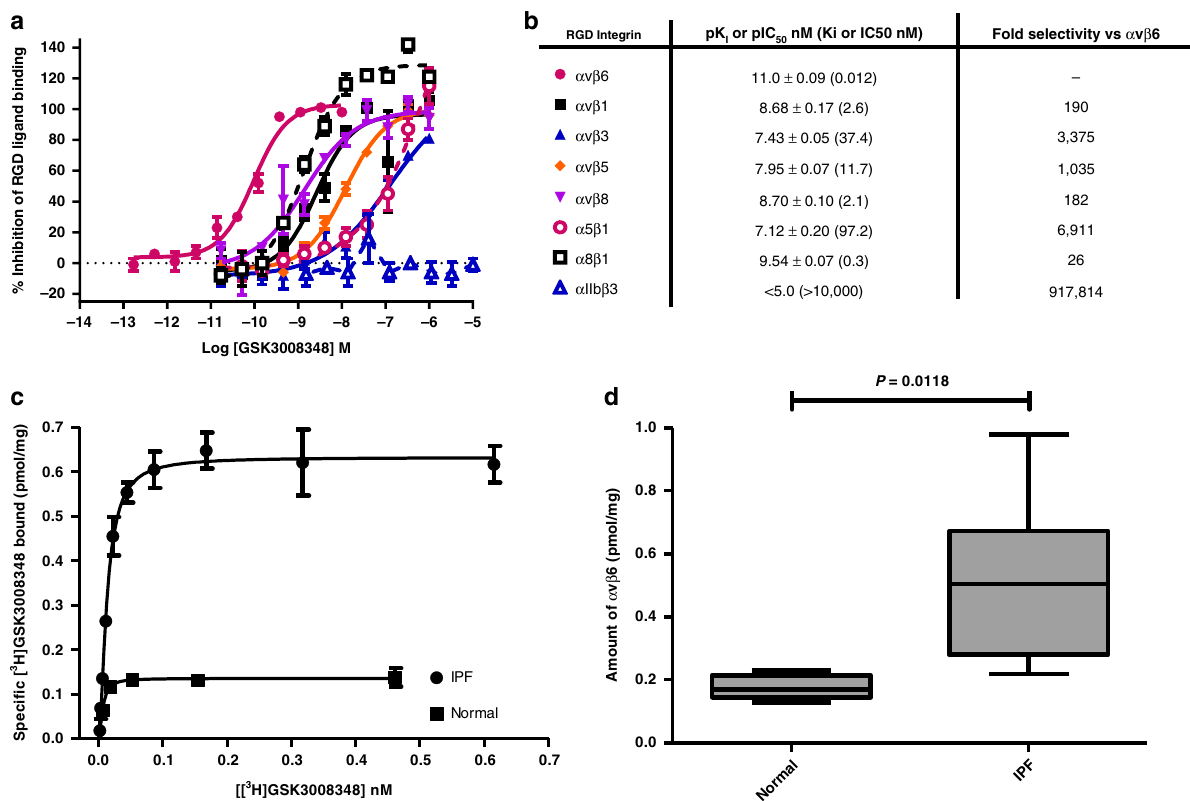
Fig. 2 High af fi nity and selectivity of GSK3008348 for the α v β 6 integrin. a Competition binding curves of GSK3008348 against the RGD integrins (mean ± SEM; n = 4). b p K I af fi nity or pIC 50 values ( α IIb β 3 only) for GSK3008348 against the RGD integrins with fold-selectivity for α v β 6 (mean ± SEM; n = 4 – 6). c Representative saturation binding curves for [ 3 H]GSK3008348 in normal and IPF human lung tissue (duplicate points shown ± min/max). d Quanti fi cation of total levels of α v β 6 levels in normal and IPF human lung tissue (Box and whisker plot shows median, fi rst and third quartiles, and max/ min values; six donors per group). Source data are provided as a Source Data fi